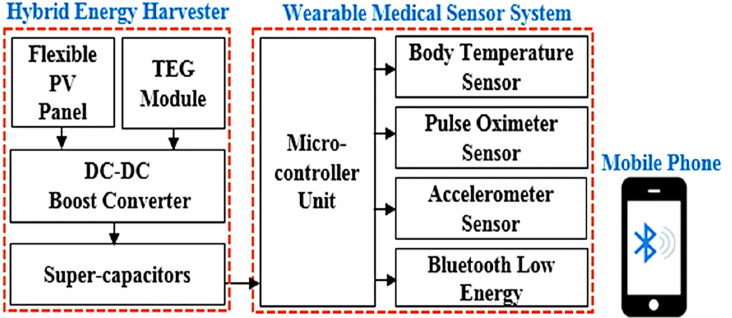
Figure 12. Architecture of the multi-source energy harvesting system to feed the sensor system